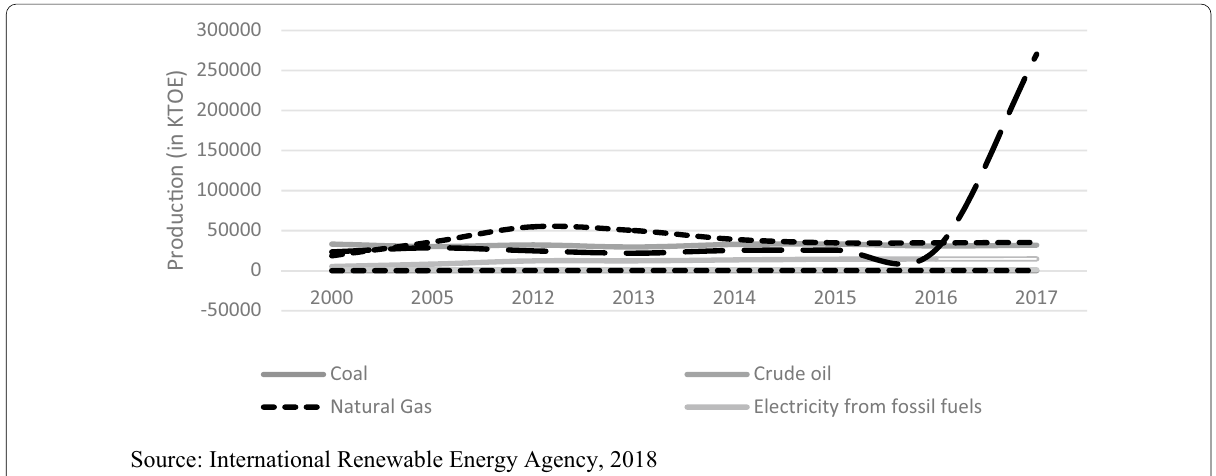
Fig. 2 Total primary energy supply in Egypt from 2000 to 2017. Source : International Renewable Energy Agency